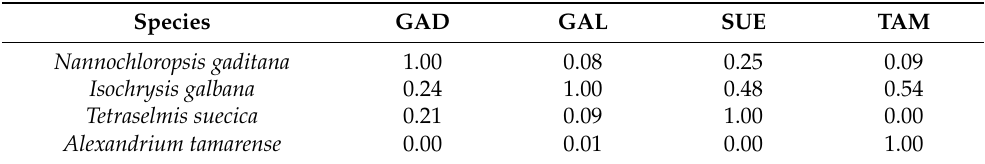
Table 7. Four identifiers (GAD, GAL, SUE and TAM) calculated from fluorescence ratios of the three